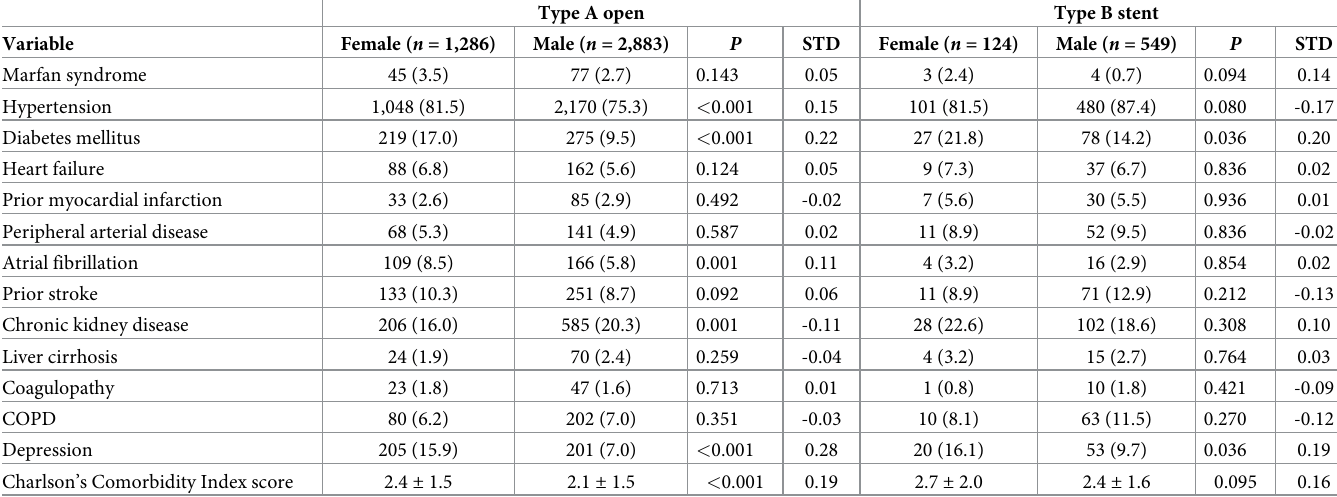
Table 2. Comorbid conditions of the female and male patients who received AAD surgery before propensity score matching. Type A open Type B stent Variable